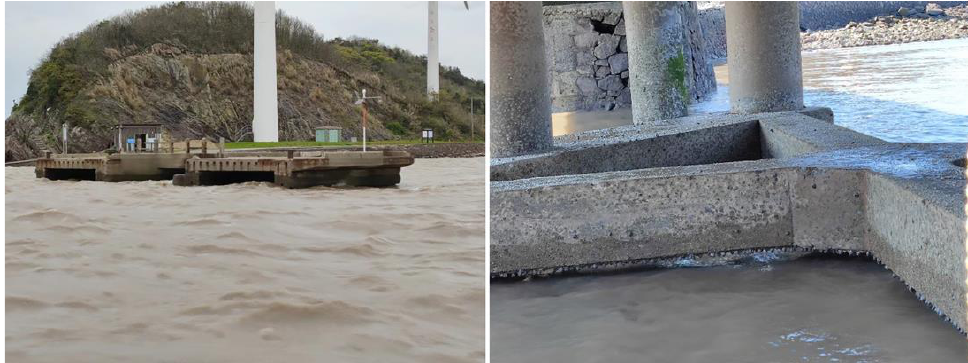
Figure 3. Overview of the wharf.